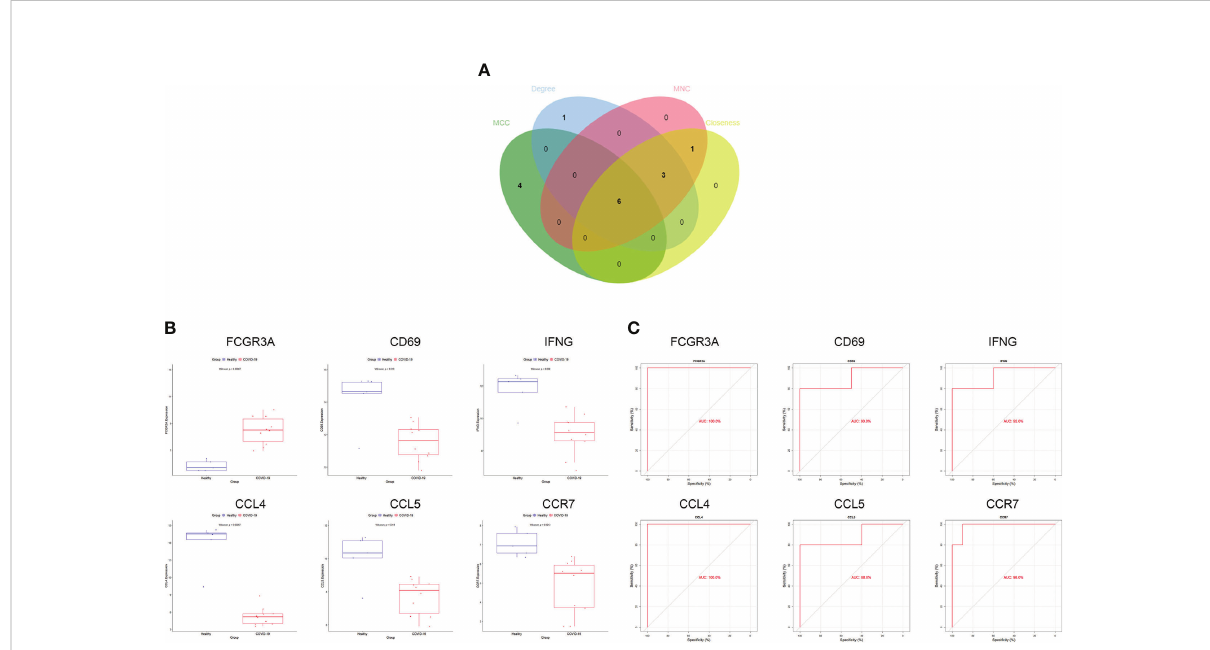
FIGURE 3 Screening and validation of hub genes. (A) Screening process of hub genes. (B) Expression of hub genes in the COVID-19 dataset; blue and red indicate the healthy and COVID-19 groups, respectively. Expression of FCGR3A was signi fi cantly higher and that of CD69, IFNG, CCR7, CCL5, CCL4 was signi fi cantly lower in COVID-19 compared to expression levels in the healthy group. (C) AUC values of hub genes in the COVID-19 dataset. ROC curves and AUC statistics were used to assess the ability to distinguish COVID-19 from healthy controls with excellent sensitivity and speci fi city. COVID-19: coronavirus disease 2019. AUC, area under the curve; ROC, receiver operating